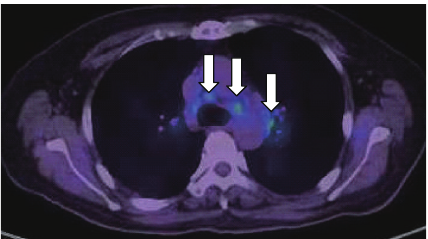
Figure5:PositronemissiontomographicimageforCase 2,showing hypermetabolic activity in the bilateral hilar lymph nodes and mediastinal lymph nodes